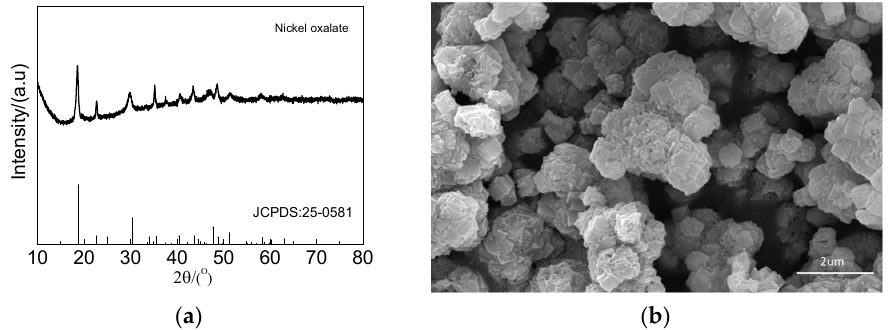
Figure 15. Characteristics of Ni precipitate: ( a ) XRD pattern and ( b ) SEM image. Li in the raffinate was precipitated by sodium carbonate after Ni precipitation. The